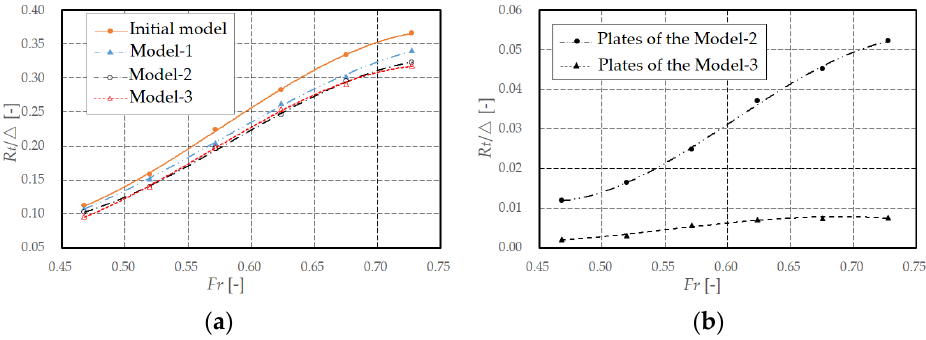
Figure 23. The resistance of the resistance improvement models and flap plates. ( a ) Total resistance of amphibious vehicles; ( b ) The resistance of the flat plates.